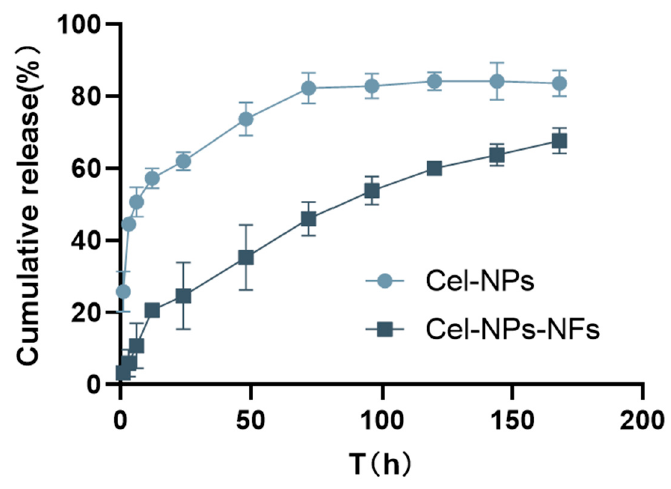
Figure 5. In vitro release curve of Cel-NPs and Cel-NPs-NFs in 168 h. Table 2. Fitting of in vitro release model.